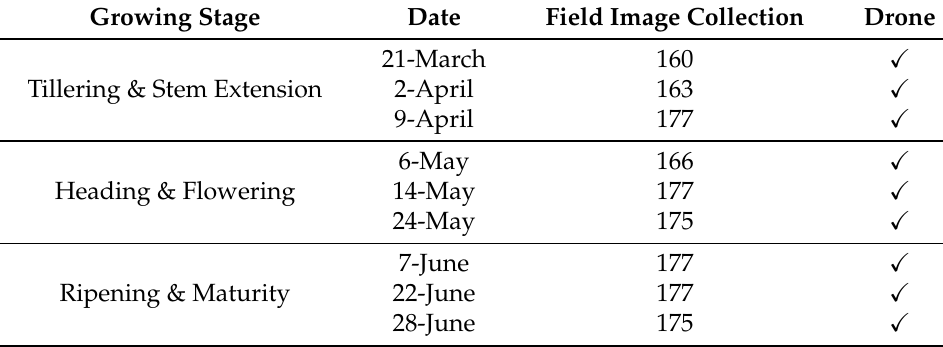
Table 1. Monitoring schedule and Data collection summary.